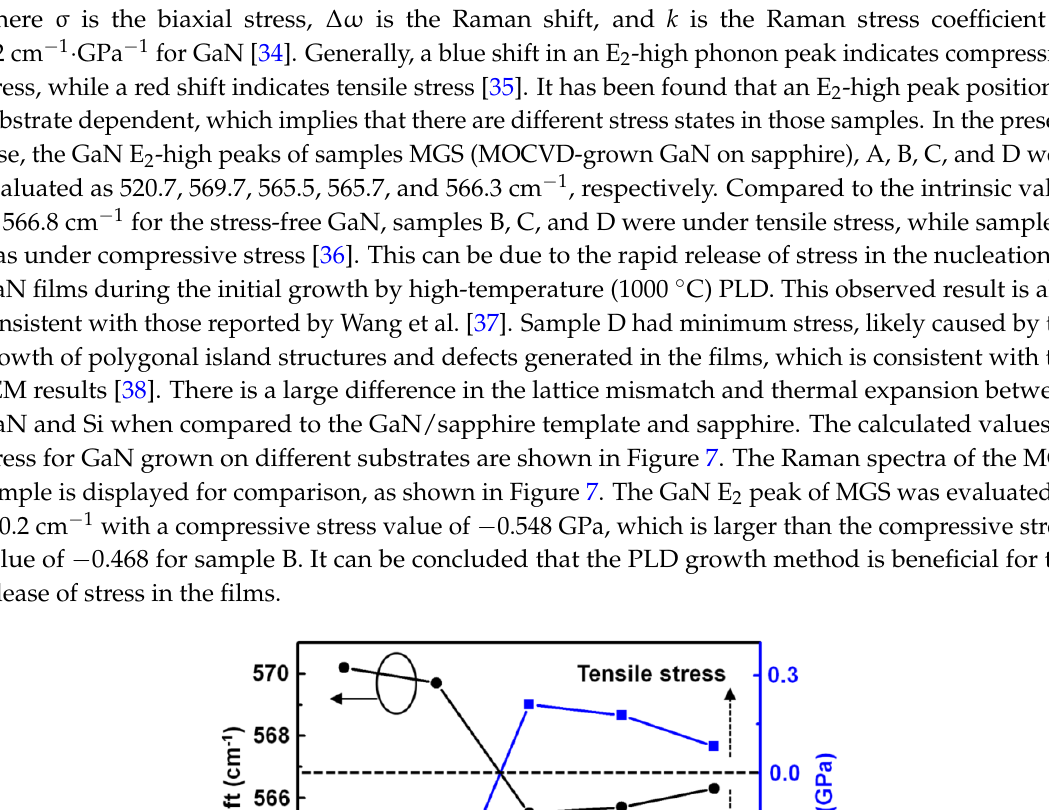
Figure 8. Cross ‐ sectional TEM pictures of GaN films on samples ( a ) C and ( b ) D.